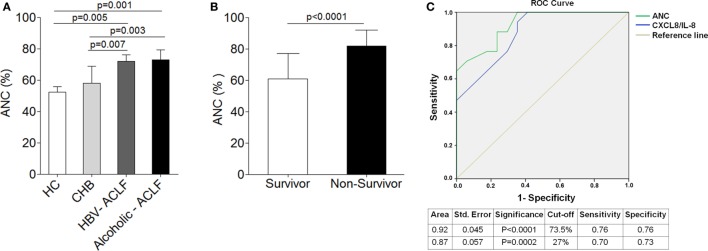
Higher neutrophil counts are associated with disease outcome and mortality in acute-on-chronic liver failure (ACLF). (A) Absolute neutrophil count (ANC) was significantly high in hepatitis B virus (HBV)-ACLF (n = 17) and alcoholic-ACLF (n = 19) than chronic hepatitis B (CHB) (n = 42) and healthy controls (HC) (24). (B) Bar graph indicates ANC in ACLF survivors (n = 17) and non-survivors (n = 17). ANC was significantly higher in non-survivors. (C) Receiver operating characteristic curve of ANC and CXCL8/IL-8 in prediction of mortality. ANC had high area under the curve 0.92 with a sensitivity of 76.5% and specificity of 76.5 than CXCL8/IL-8.